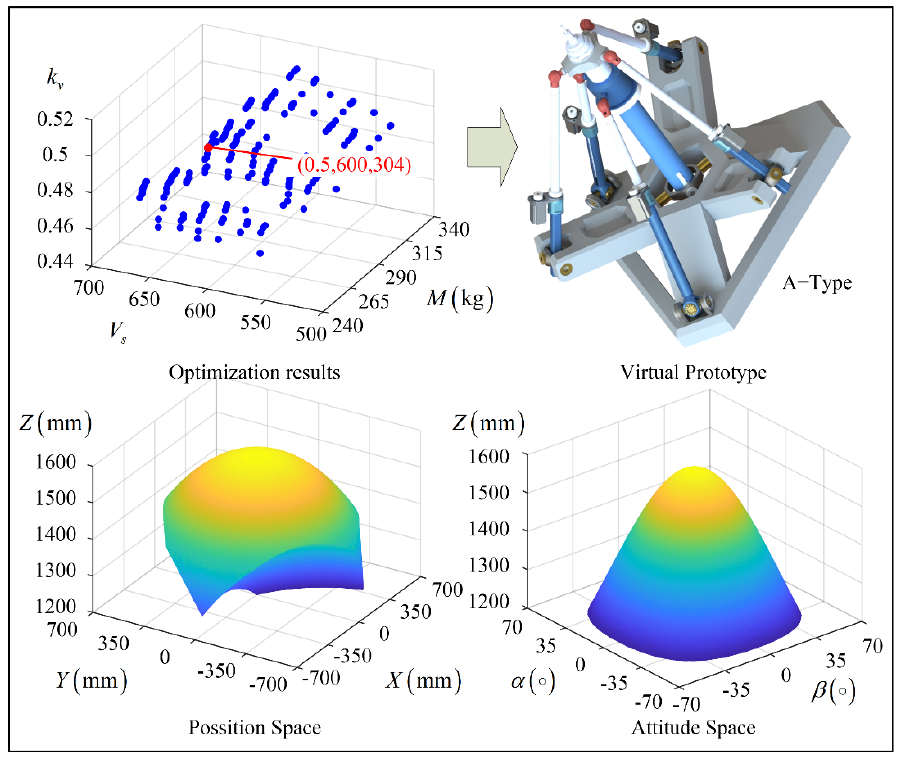
Figure 5. Result A.